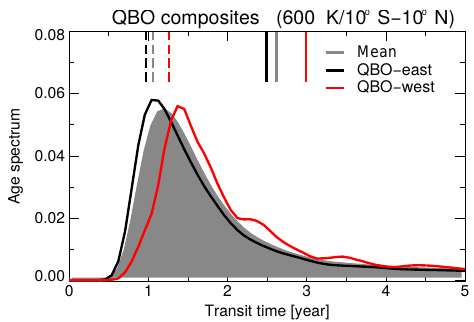
Figure 12. Age spectrum composites for easterly (black) and west- erly (red) QBO phases, calculated from tropical (10 ◦ S–10 ◦ N) CLaMS age spectra at 600K. Mean ages are shown as solid ver- tical lines, RCTTs as dashed lines. The climatological mean spec- trum, mean age and RCTT are shown in grey. (For better clarity of the differences, the westerly/easterly composites have been defined using the condition that ERA-Interim tropical mean zonal winds at 600K go above/below ± 10ms − 1